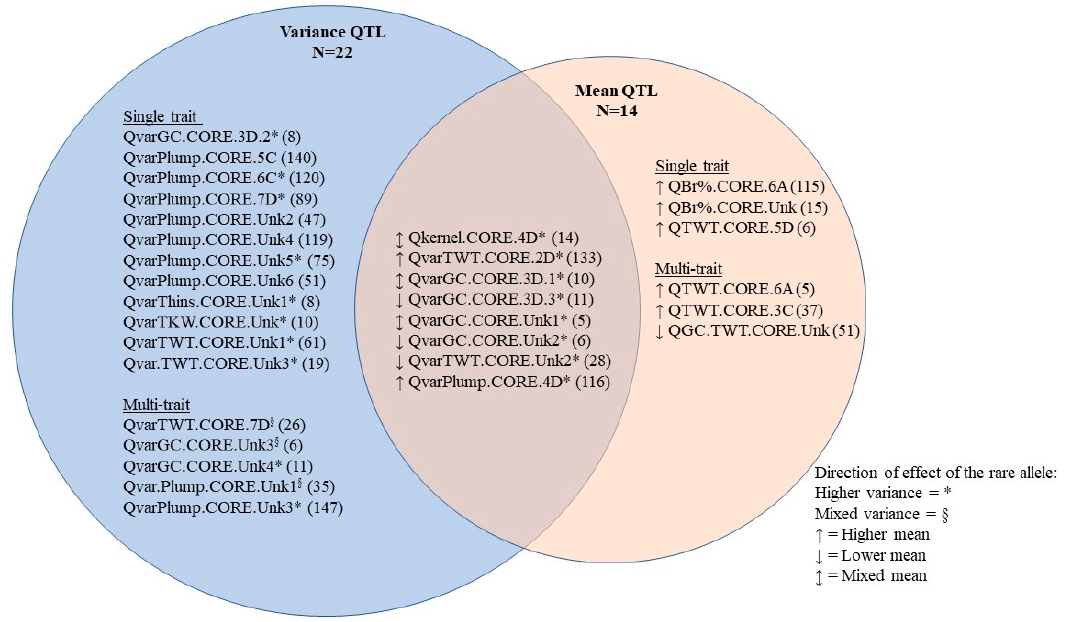
Figure 1. QTL grouped by influence over means and variances of milling quality characteristics. QTL are named using traits for which association at p ≤ 1.41 × 10 − 6 and classified as influencing a single trait or multiple traits based on associations at p ≤ 0.01. Direction of effect of the rare allele summarizes all associated traits. The number in parentheses is the number of rare allele homozygotes in the sample.